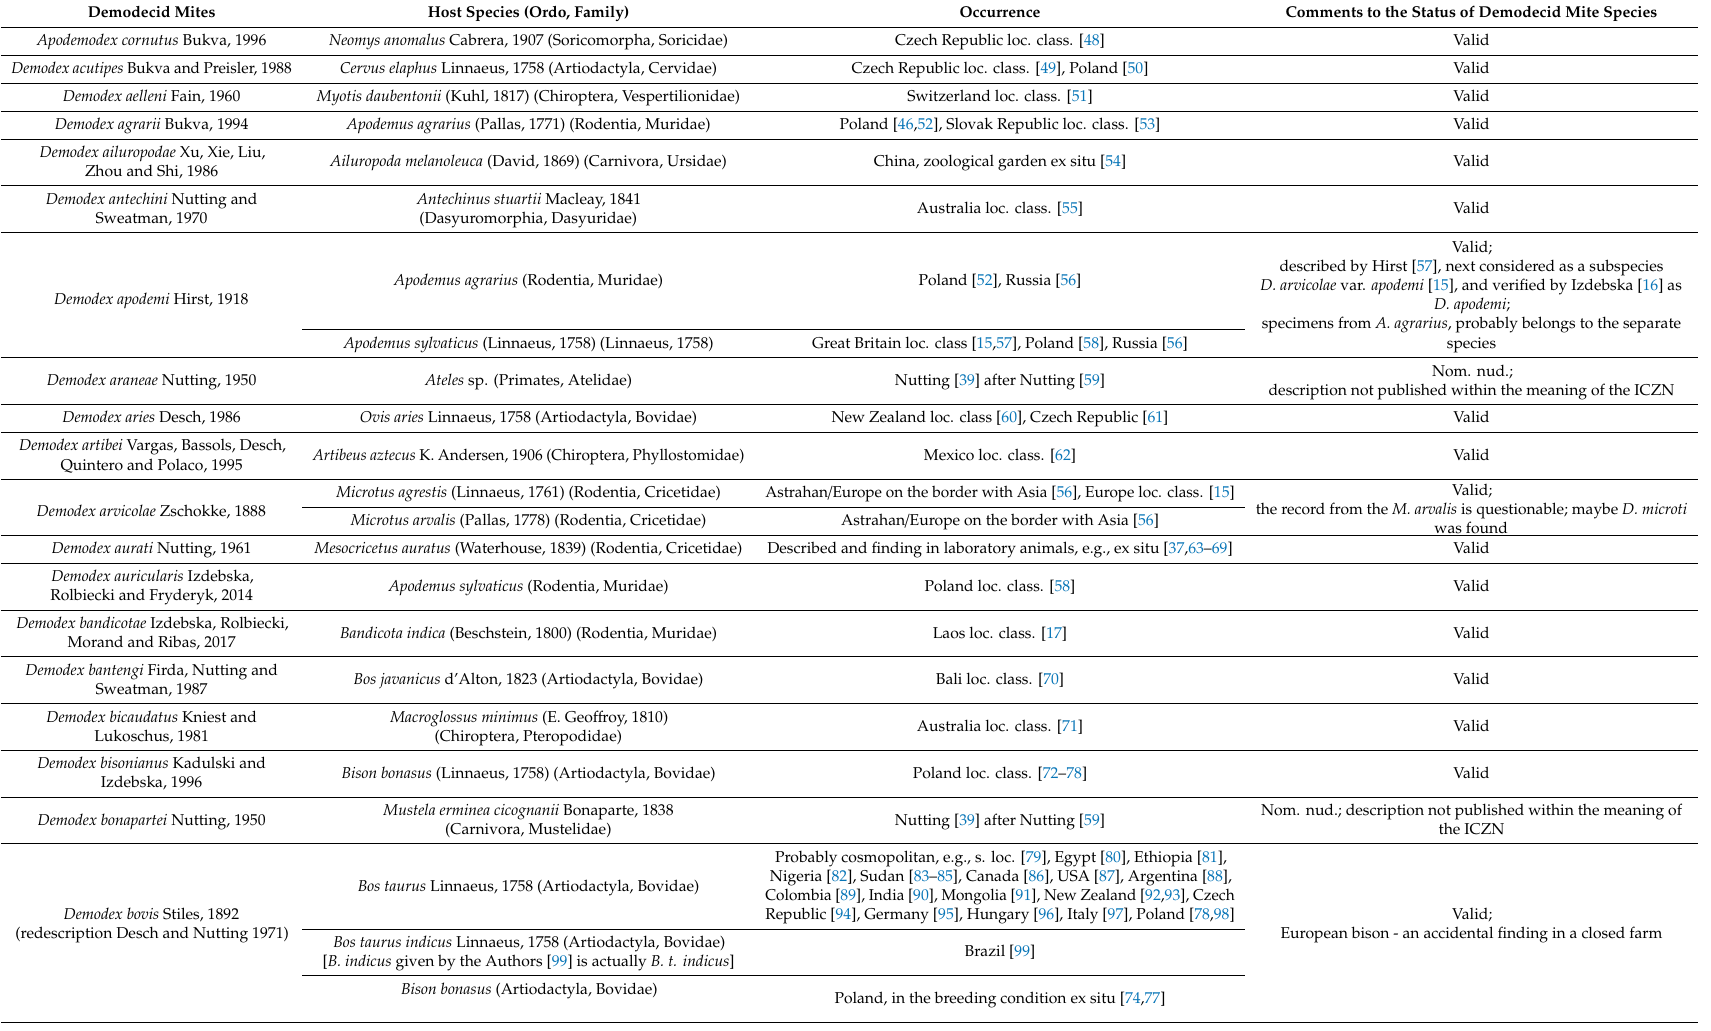
Table 1. Checklist of demodecid